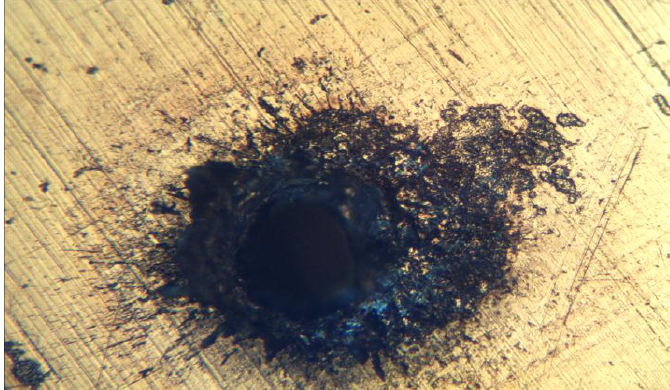
Fig.3: Top view image of a hole drilled in aluminum (100X) by 100 mJ laser pulse.